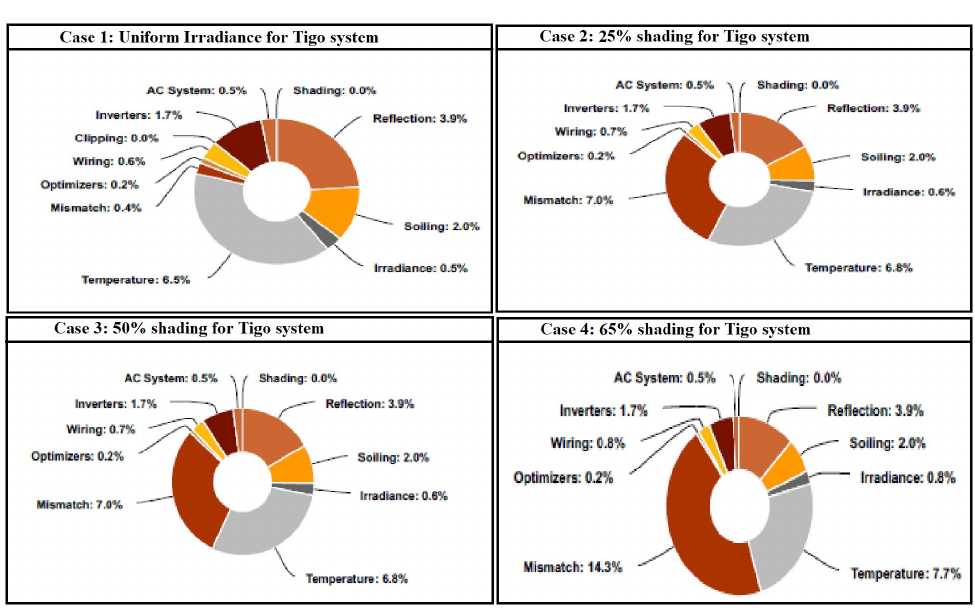
Figure 37. Results of various losses of Tigo solar system on different shading conditions using